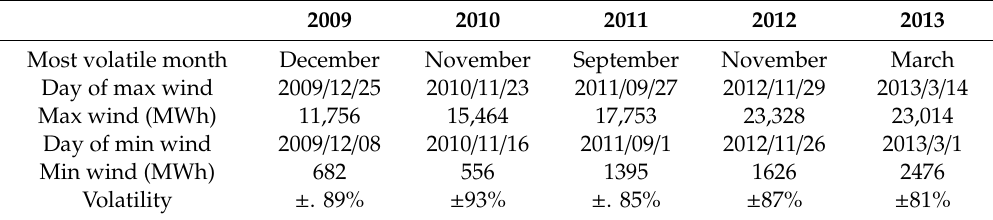
Table A4. The volatility of wind RES-E generation in Greece during the period of 2009–2013.